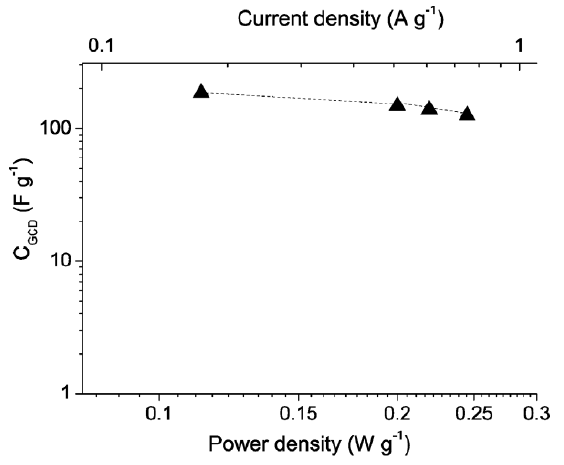
Fig. 10. Regone-type plot showing specific capacitances measured at different power densities, obtained from galvanostatic measurements for bioC_31. (1 M H SO 2 4